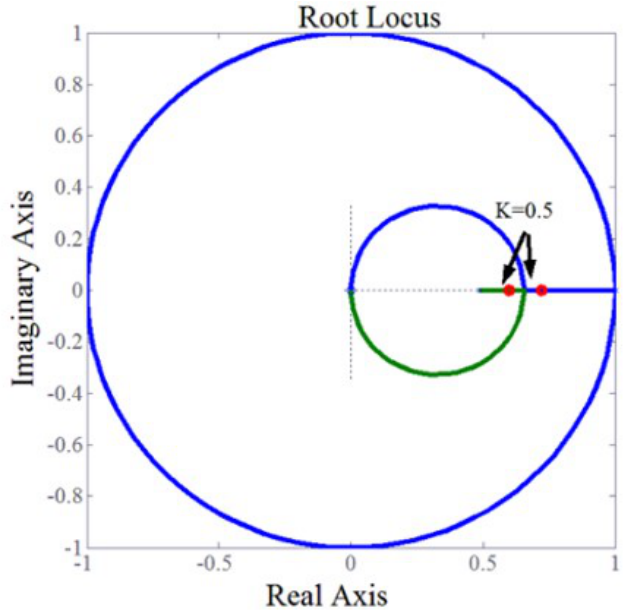
Figure 4. Root locus for the SFBARMA SDN